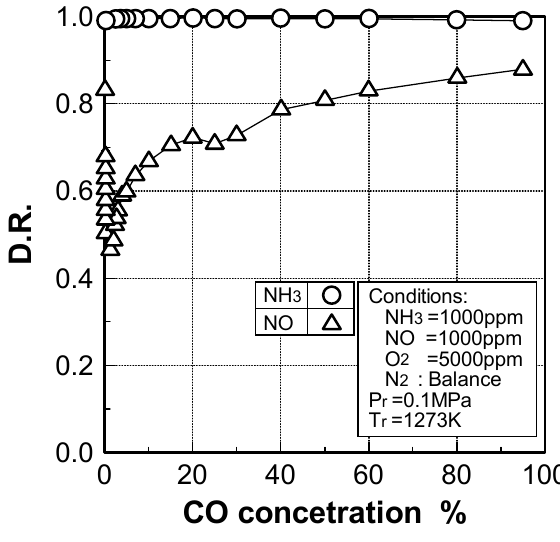
-NO-O -CO system as defined by experiments. 3 2